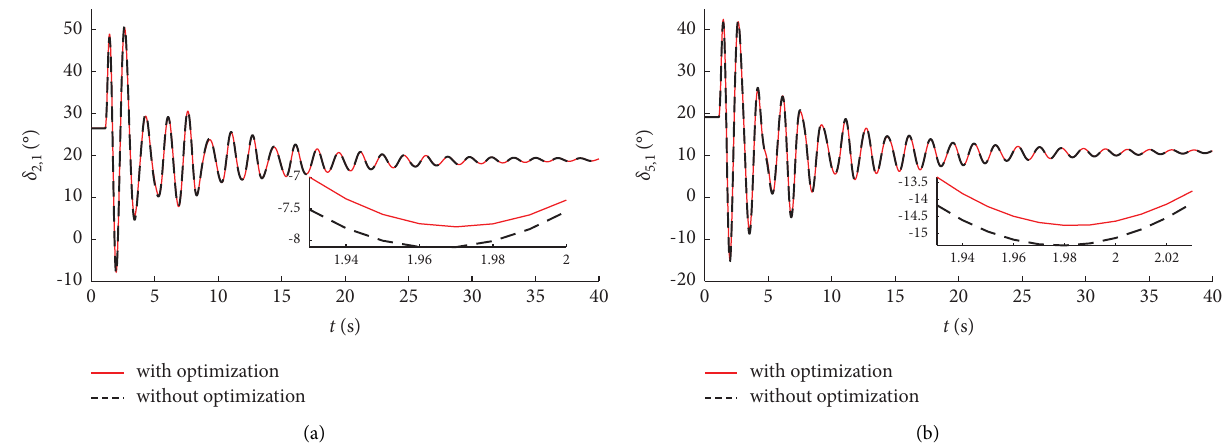
DC,ref . (a) Power angle diference between #2 and #1 SGs.